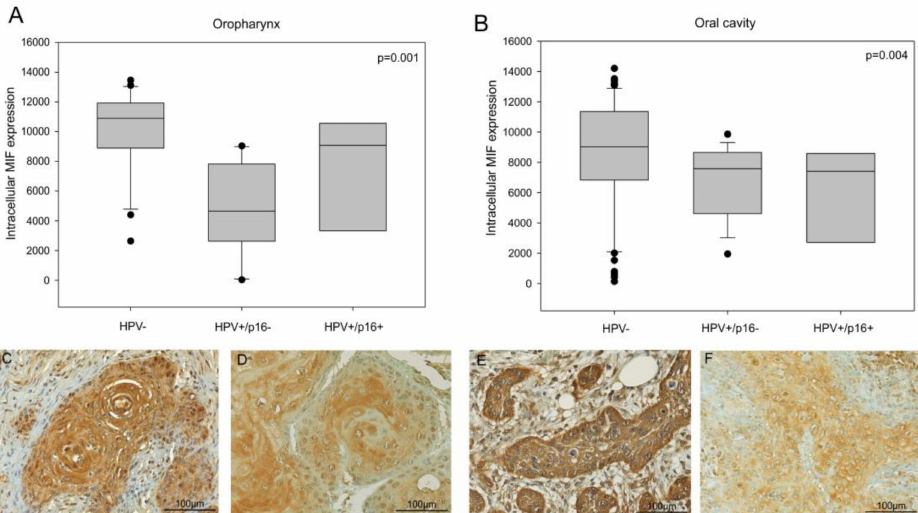
Figure 1. Intracellular migration inhibitory factor (MIF) expression in head and neck cancer patients. ( A ) Quantitative analysis of MIF expression in a series of 39 oropharyngeal cancer patients, including 21 Human Papilloma Virus negative (HPV-ve) cases and 18 HPV+ve cases ( p = 0.001, Kruskal–Wallis test) and ( B ) 117 oral cavity cancer patients, including 65 HPV-ve cases and 52 HPV+ve cases ( p = 0.004, Kruskal–Wallis test). ( C , D ) Immunohistochemistry of MIF in HPV-ve ( C ) and HPV+ve ( D ) oropharyngeal cancer cases and ( E , F ) in HPV-ve ( E ) and HPV+ve ( F ) oral cavity cancer